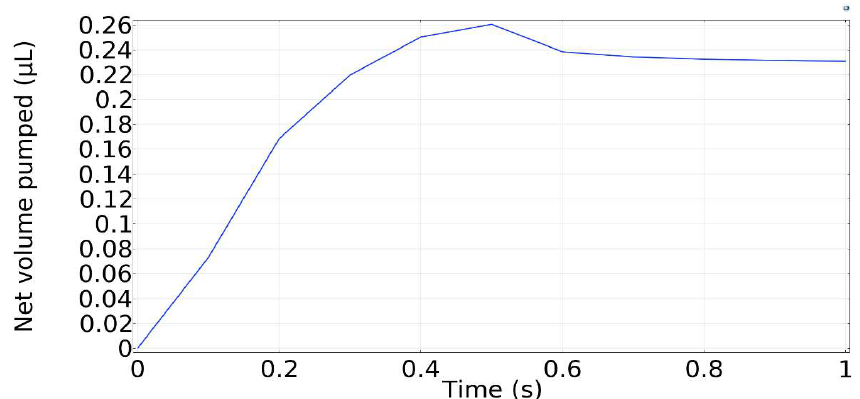
Figure 15. Net pumped volume.